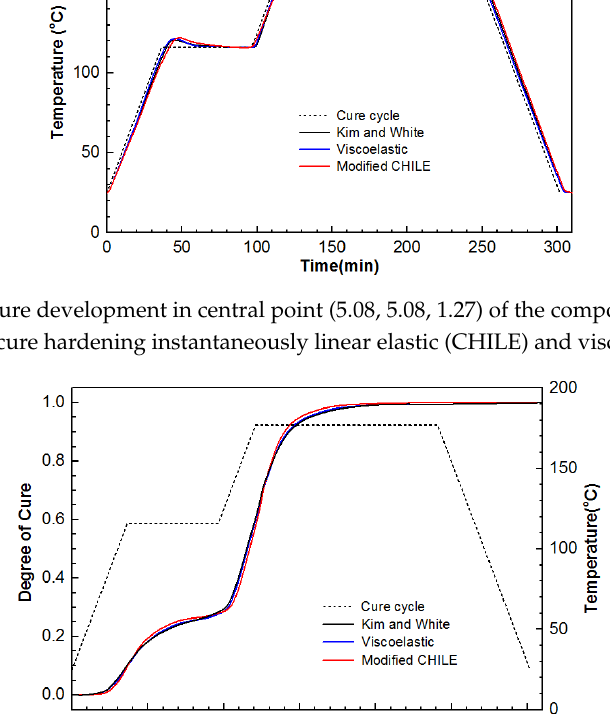
Figure 6. Distribution of temperature on the cross section at x = 5.08 in the course of curing from the viscoelastic model. ( a ) 32 min; ( b ) 46 min; ( c ) 118 min; ( d ) 133 min; ( e ) 290 min; ( f ) 301 min. 5.2. Residual Stress Analysis The major factor leading to residual stress generation is the cure shrinkage, i.e., the chemical shrinkage and thermal strains arising from CTE (Equation (6)). Figure 7 shows the altered state of